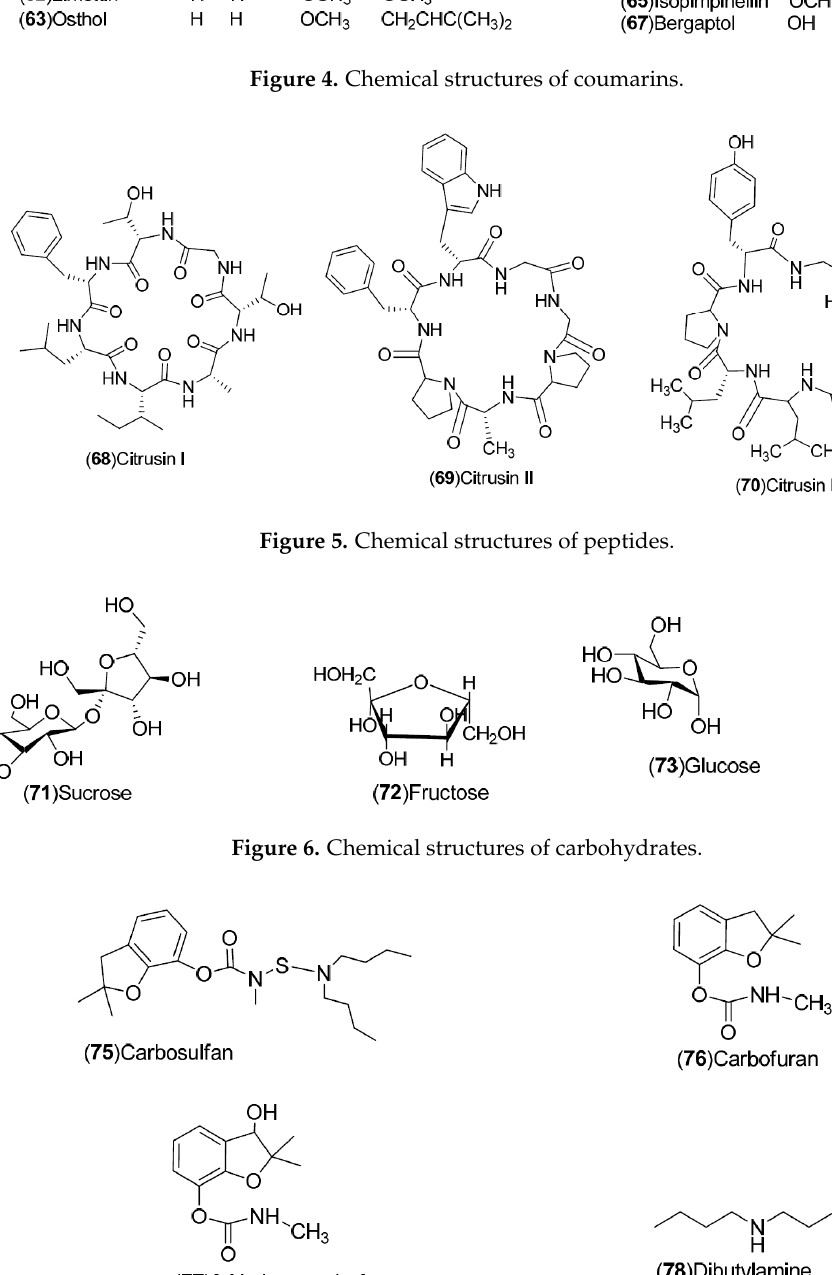
Figure 7. Chemical structures of carbamates and alkylamines.